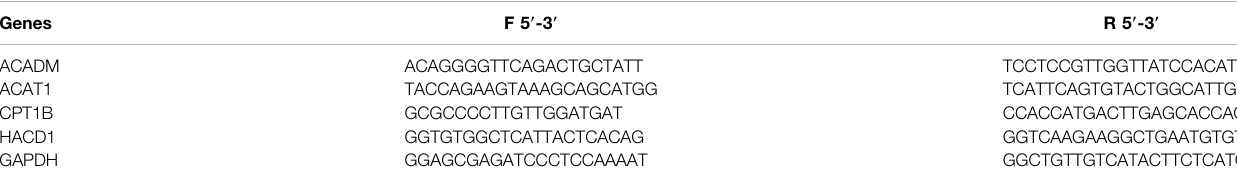
TABLE 1 | Primers of ACADM, ACAT1, CPT1B, HACD1, and GAPDH.